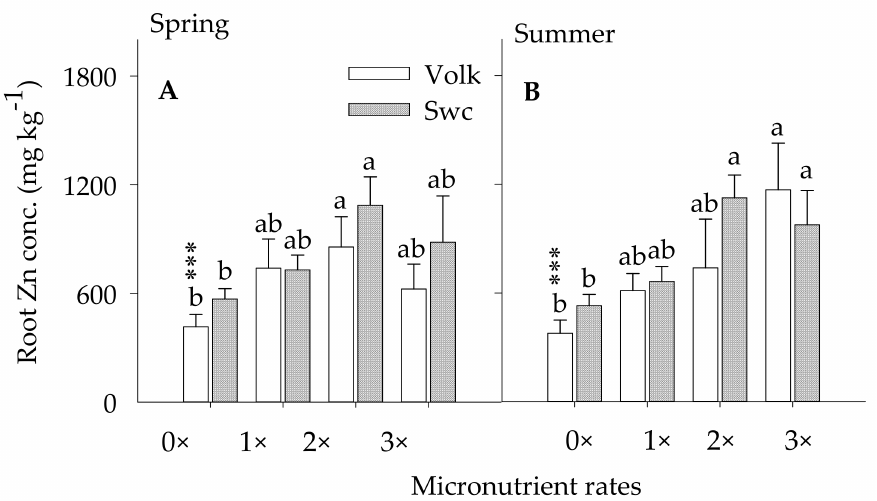
Figure 4. Root Zn concentration as affected by foliar and /or ground-applied micronutrients during spring (figure ( A )) and summer (figure ( B )) of 2017–2018 growing seasons. Micronutrient treatments (X-axis): control (0 × ), foliar (1 × ) (1 × ), foliar (1 × ) and ground (1 × ) (2 × ), and foliar (1 × ) and ground (2 × ) (3 × ), (1 × = 9 kg ha − 1 of metallic Mn and Zn each and 2.3 kg ha − 1 of B). Error bars indicate the mean values ( n = 12 trees) ± standard error of the mean for trees budded on Volkameriana (Volk) or Swing (Swc) rootstocks. Asterisks (***) indicate significance at p ≤ 0.0001. Means along the same vertical alignment with the same lower case letters are not significantly different ( p ≤ 0.05) using the Tukey’s range